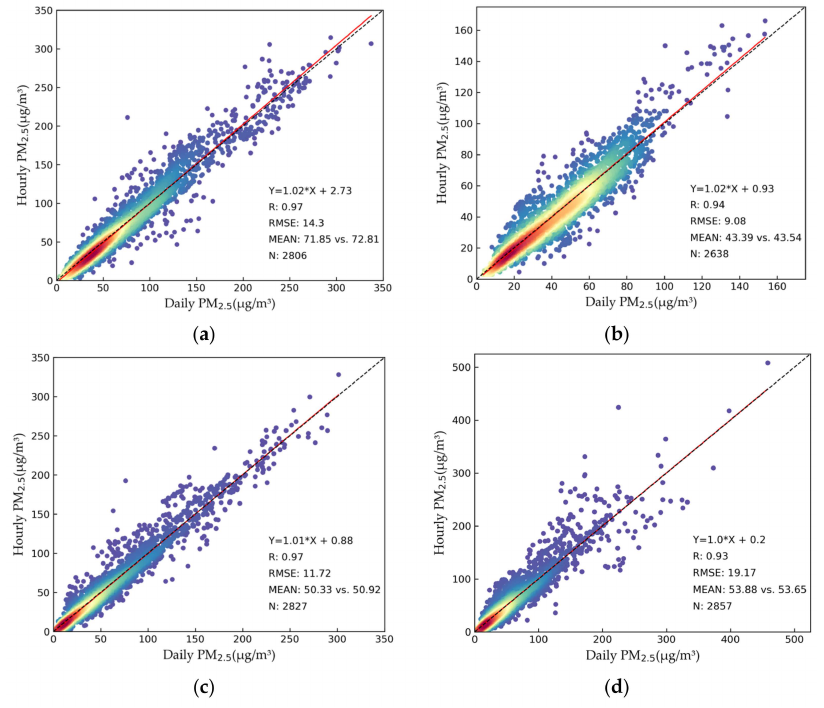
Figure 4. Inter-comparison between hourly mean PM 2.5 ( y -axis) measured at overpass time of NPP (2:00 CST) and Terra (11:00 CST) and daily PM 2.5 ( x -axis): ( a – d ) is in spring, summer, autumn, and winter, respectively. The dashed line is the 1:1 line as a reference.